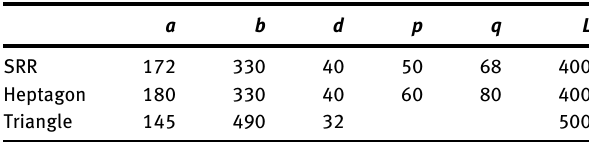
Table  : Structural parameters (nm) for double resonant